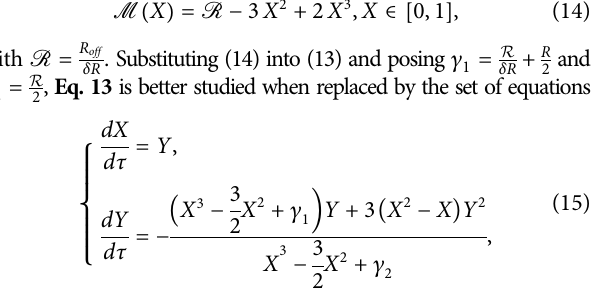
(cid:1) 0 V , 1 0 ( t ) and V ( t ) 1 2